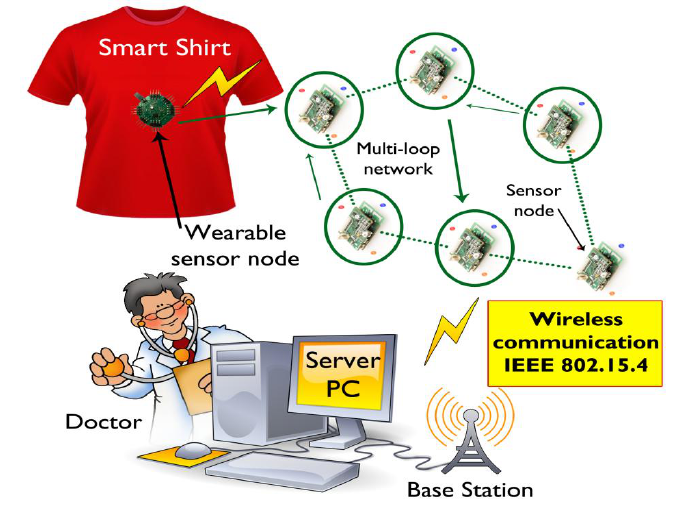
Figure 5. The system architecture with a wearable smart